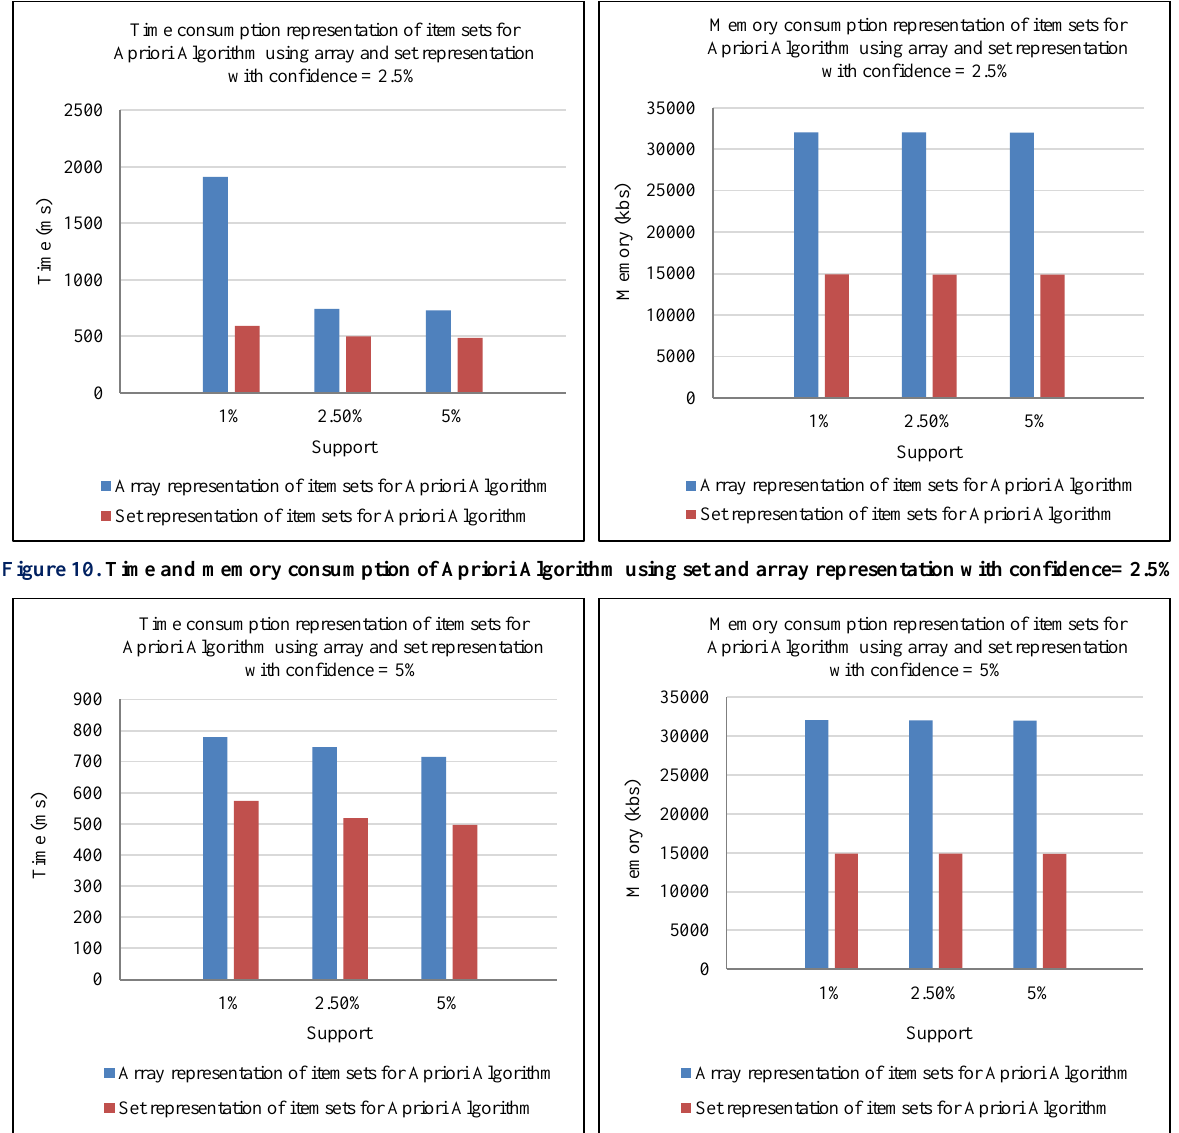
Figure 9. Time and memory consumption of Apriori Algorithm using set and array representation with confidence= 1%.